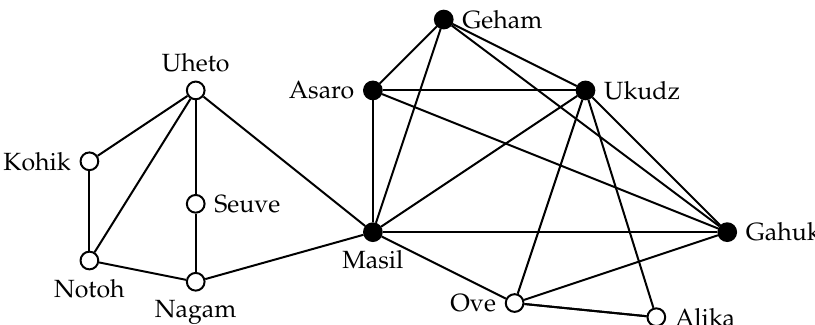
Figure 1. A part of the highland tribes social network [4]. The black vertices form the maximum clique in this